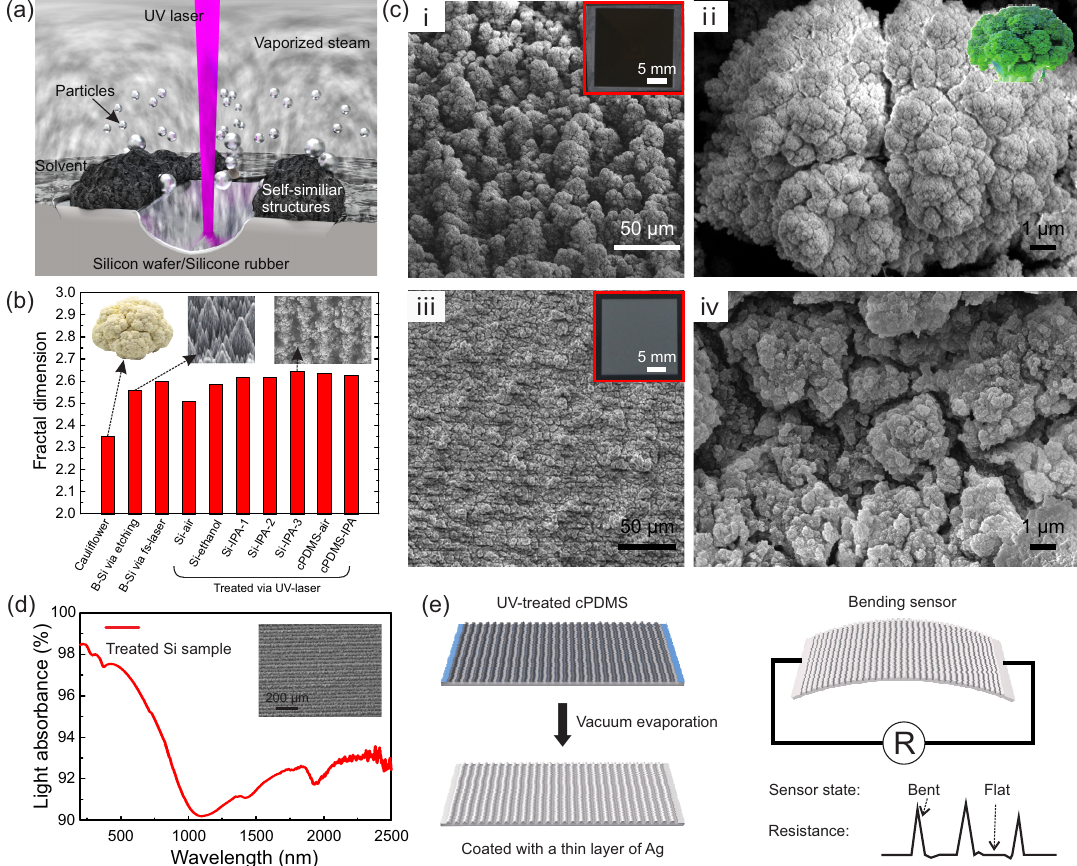
Figure 1. Fabrication, observation, and characterization of self ‐ similar hierarchical micro–nano structures on diverse surfaces. ( a ) Schematic fabrication process of hierarchical structures with a solvent ‐ assisted UV ‐ lasering. ( b ) Micro ‐ views of the treated Si sample with an area of 2 × 2 cm 2 under v = 15 mm/s and Δ L = 0.02 mm in the IPA ( i , ii ) and cPDMS ( iii , iv ) samples with an area of 2 × 2 cm 2 under v = 400 mm/s and Δ L = 0.01 mm in IPA. ( c ) Calculated fractal dimensions of several self ‐ similar surfaces. ( d ) The light absorbance of a treated Si sample in the range of 200–2500 nm. The inset shows a magnified view of the sample. ( e ) An illustration of the UV ‐ treated cPDMS sample coated with a